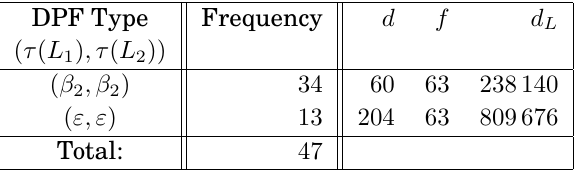
Table 22: Types of doublets with a split prime divisor of irregular f